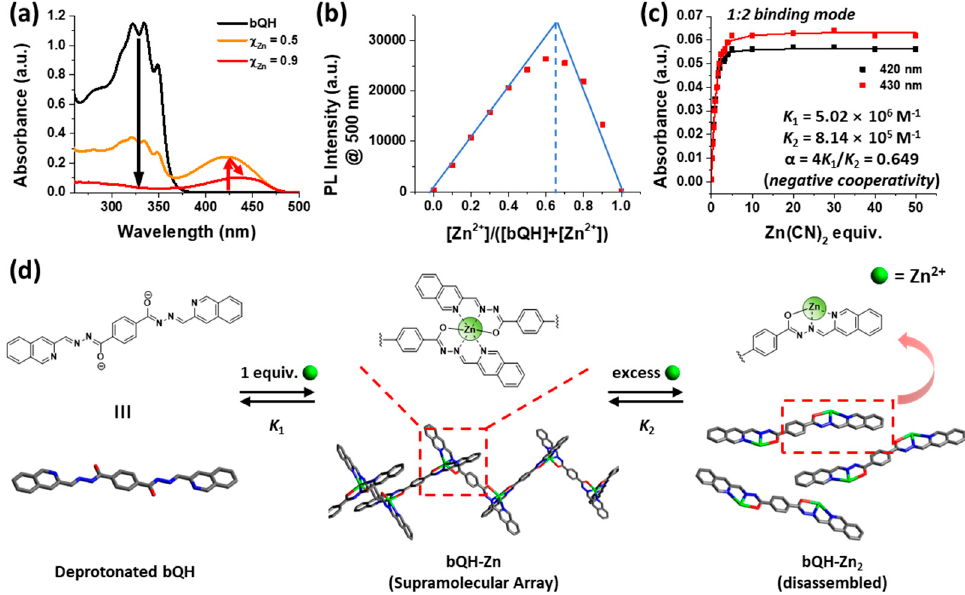
Figure 3. Study of the binding mechanism with ultraviolet-visible (UV–Vis) and PL spectroscopy. ( a ) The absorption spectra of a solution of bQH (1.0 × 10 − 5 M in DMSO) with increasing ratio of Zn 2 + ion performed for the Job’s plot of bQH-Zn 2 + ([bQH] + [Zn 2 + ] = 2.0 × 10 − 5 M). ( b ) Corresponding Job’s analysis of bQH-Zn 2 + with PL data. ( c ) The nonlinear regression analysis of absorption titration at 420 (black) and 430 nm (red) with the binding mode 1:2. ( d ) Schematic representation of the binding mechanism of bQH-Zn 2 + . The coordination occupied by any solvent molecules or ligands have been omitted for clarity.